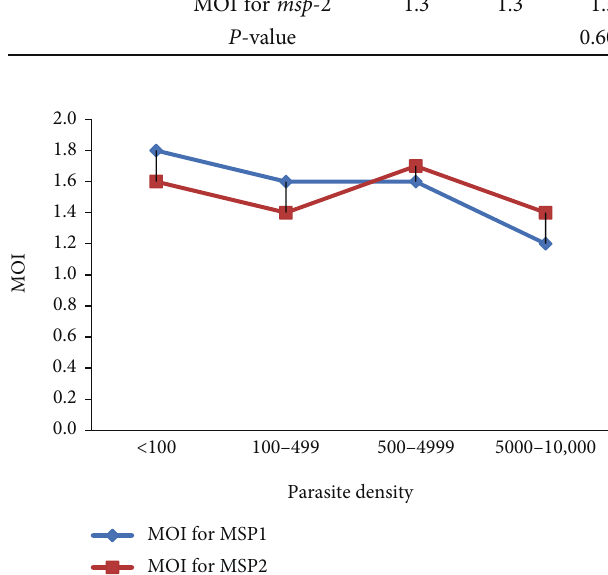
Figure 2: Relationship between multiplication of infection (MOI) and parasite density, parasite per μ